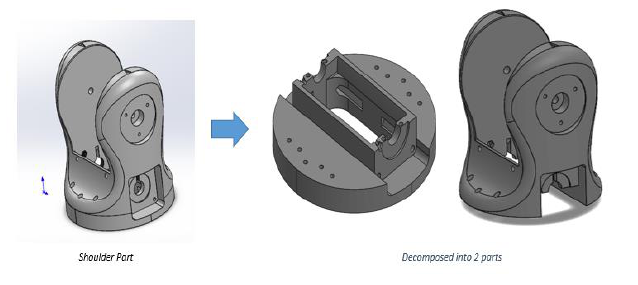
Fig. 13. Part decomposition